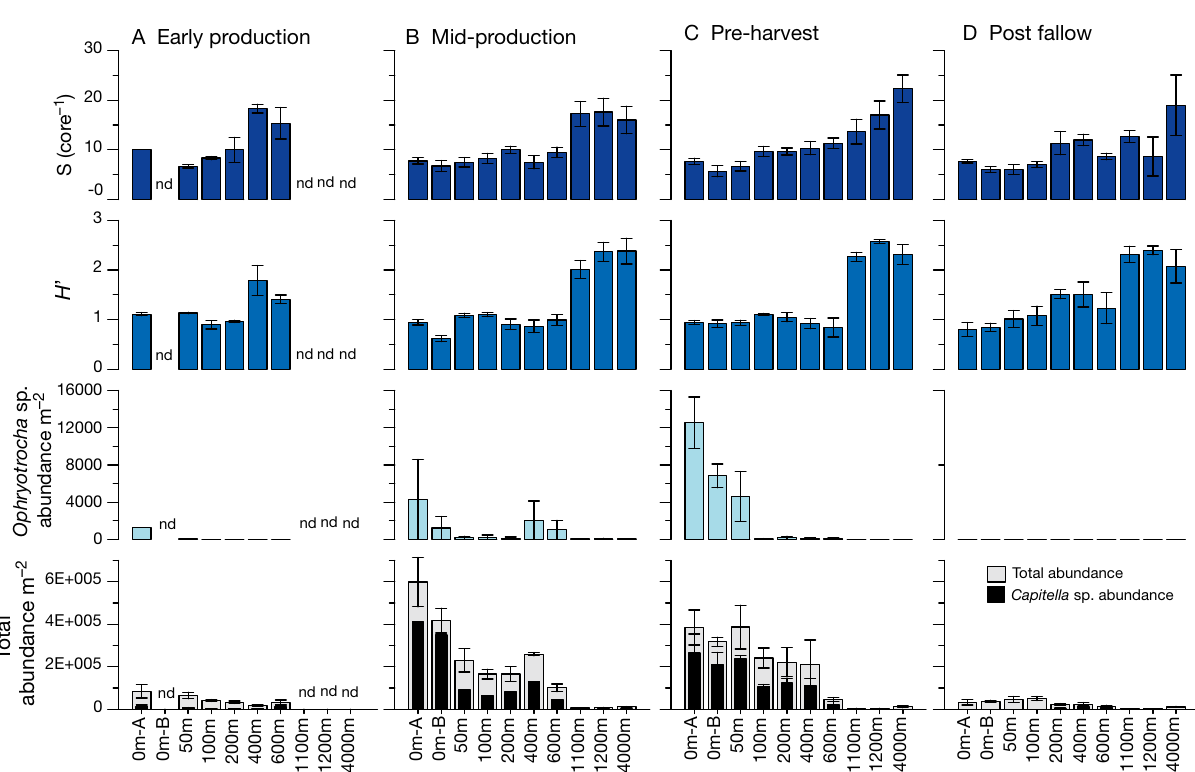
Fig. 6. Average macrofauna count data statistics during the 4 survey periods, showing number of taxa (S), Shannon diversity ( H ’) Ophryotrocha sp. abundance and total abundance (including Capitella spp. abundance) for each sampling station (labeled according to distance to nearest farm) during each survey. Error bars represent ±1 SE; nd: no